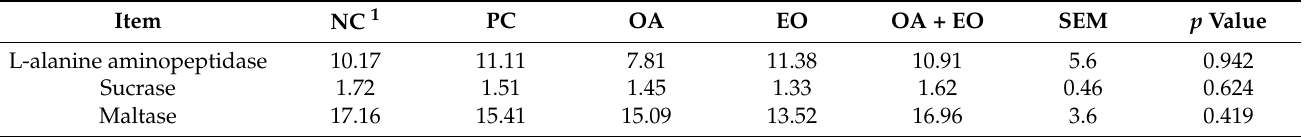
Table 6. Effects of individual or combination of organic acids and essential oils on the activities of L-alanine aminopeptidase (nmol p-nitroaniline liberated/mg protein · min), sucrase (nmol glucose released/mg protein · min), and maltase (nmol glucose released/mg protein · min) in the jejunum of broiler chickens on D